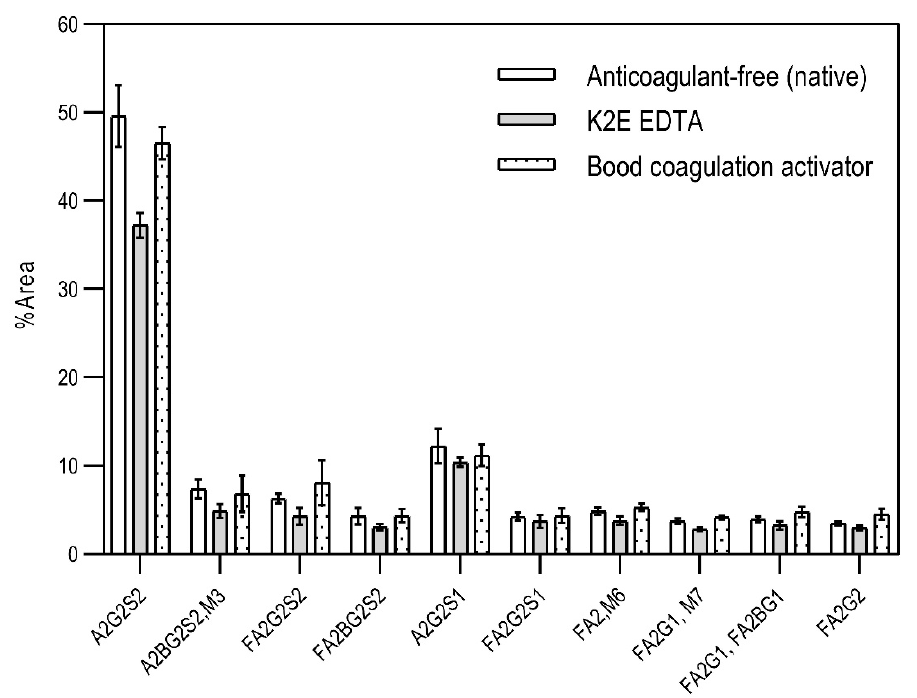
Figure 1. The effect of different types of blood-collection tubes on the resulting N -glycan profiles of whole blood (healthy) after two months with 5 intermittent re-freezing cycles. Separation conditions: 30 cm total (20 cm effective) length, 50 µm i.d. bare fused silica capillary at 20 °C, HR-NCHO separation gel buffer, two-stage injection: 5.0 psi for 5 s water plug → 6.0 kV for 3 s sample.